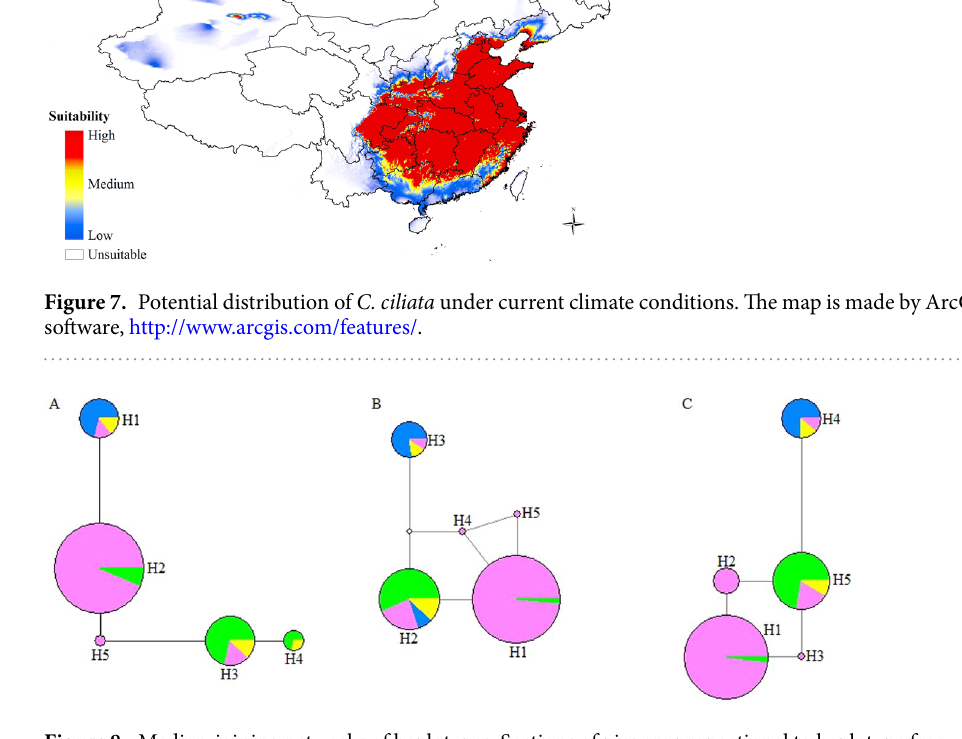
Figure 8. Median-joining networks of haplotypes. Sections of pies are proportional to haplotype frequency. ( A , B and C ) represent COI , ND1 and ND5 , respectively. Pink, Group 1; blue, group 2; green, group 3; and yellow, group 4.